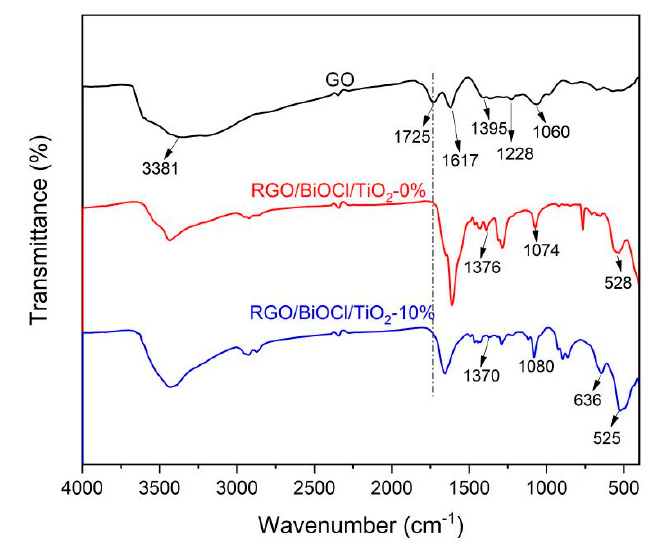
Figure 1. FT-IR spectra of GO and RGO/BiOCl/TiO 2 nanocomposites with different TiO 2 contents.